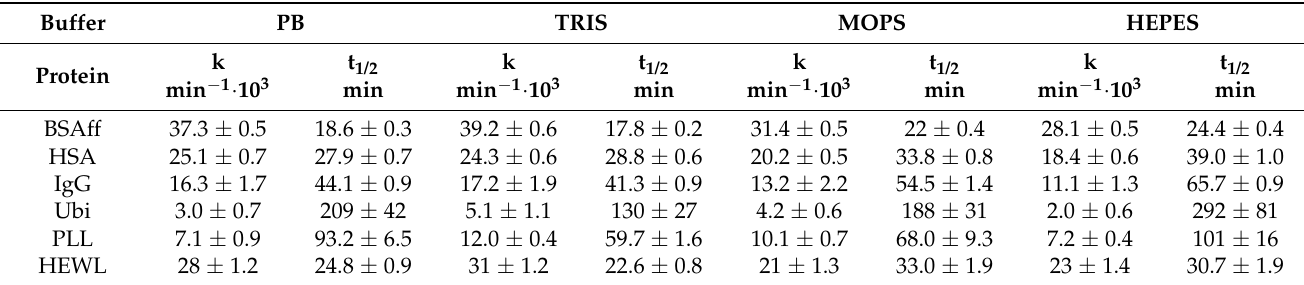
Figure 1. UV-denaturation experiments of BSAff. ( A ) 50 consecutive repeated scans of BSAff (6.8 µ M) in 10 mM phosphate buffer, pH 7.00. (insert) Time-course of CD values at 192 nm versus scan numbers. ( B ) Secondary structure estimation of BSAff throughout the UV-denaturation experiment. Spectra were acquired in the 185-260 nm range at module B end station of beamline B23 at Diamond Light Source synchrotron facility, Harwell Science and Innovation Campus (Didcot, UK), using a 0.02 cm quartz cuvettes and 0.5 mg/mL (7.6 µ M) protein concentration. Bandwidth was 1 nm, scan speed was 39 nm/min, and top-up mode ring current of 300 mA.